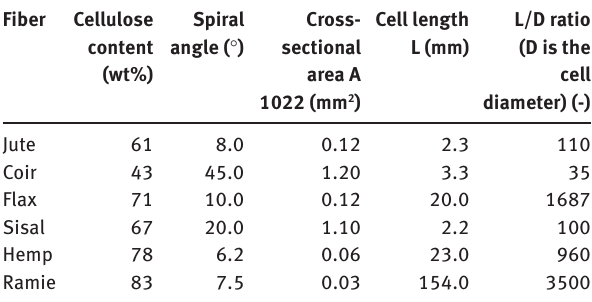
Table 4: Structure parameters of different cellulose-based natural fibers [7].